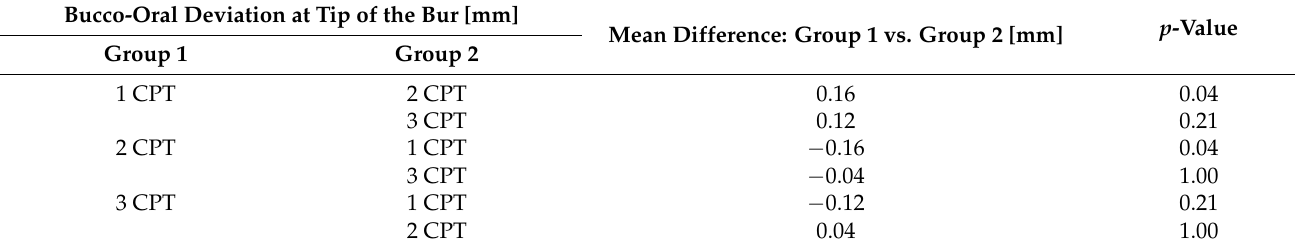
Table 4. Mean difference in bucco-oral deviation at the tip of the bur between planned and prepared access cavities according to the number of main root canals per tooth